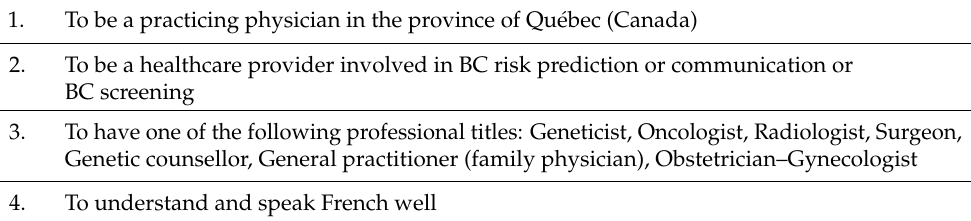
Table 1. Inclusion criteria of potential